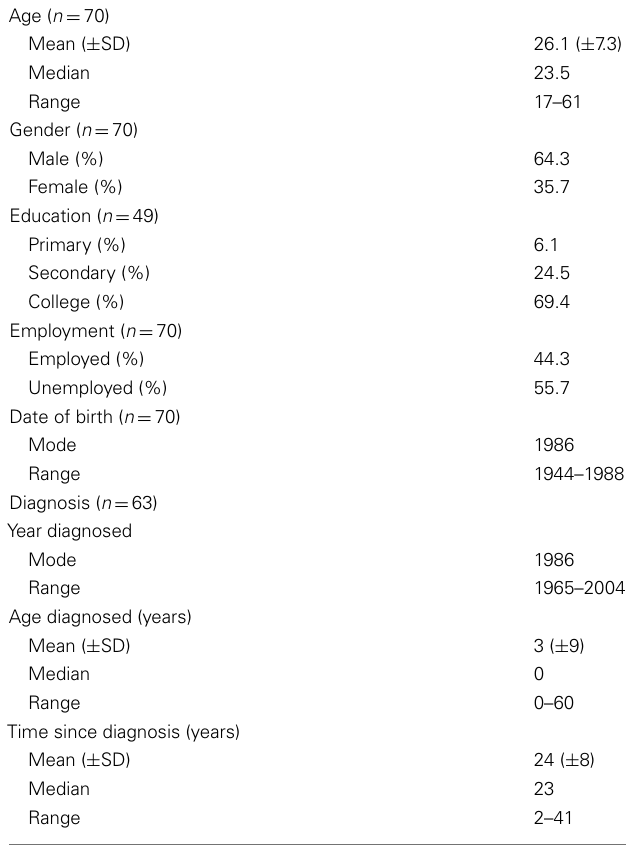
Table 2 | Socio-demographic characteristics of the study participants.